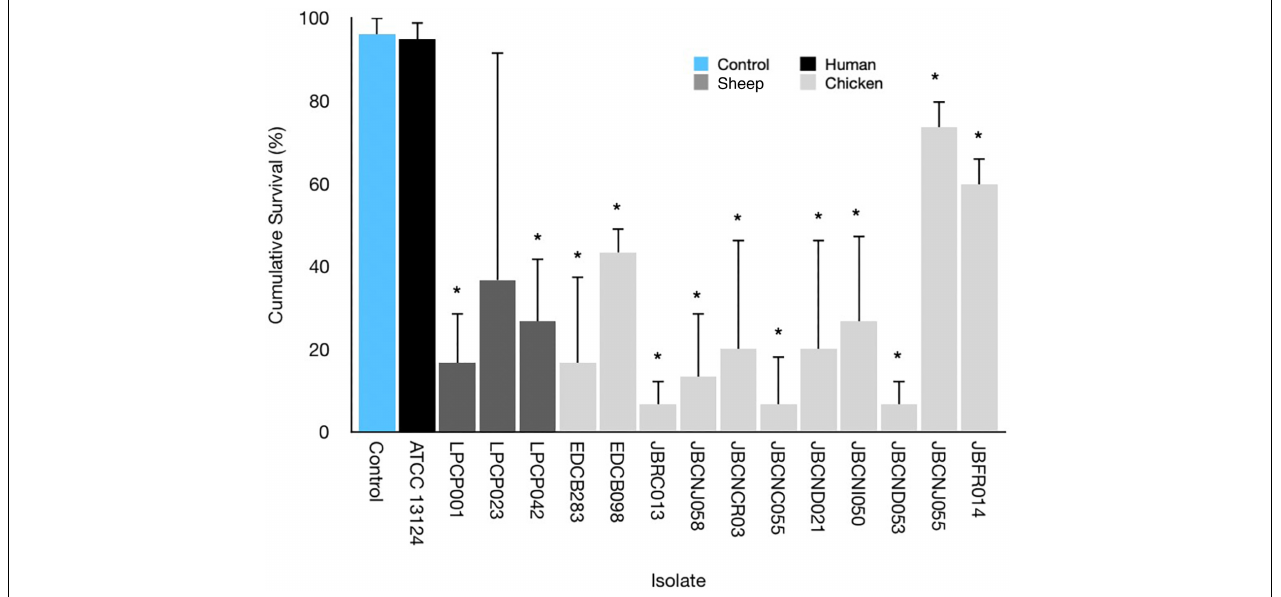
FIGURE 3 | Average survival percentage at 72 h incubation for G. mellonella infected with 10 µ L of 10 7 CFU/mL of respective isolates. Error bars indicate standard error. Results indicate a variance in lethality of C. perfringens infection toward G. mellonella . ∗ = Mann–Whitney U -test comparing larval survival to uninfected control.